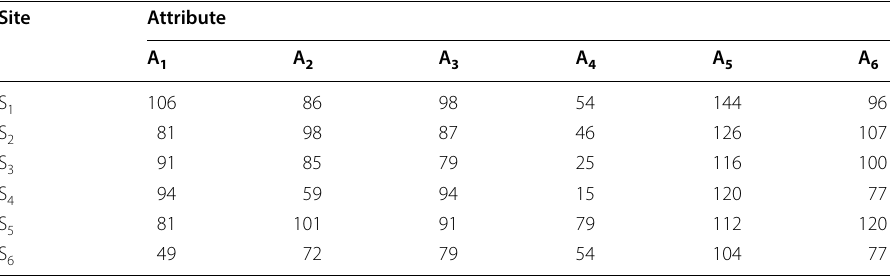
Table 14 Net Access Cost Matrix (NACS)